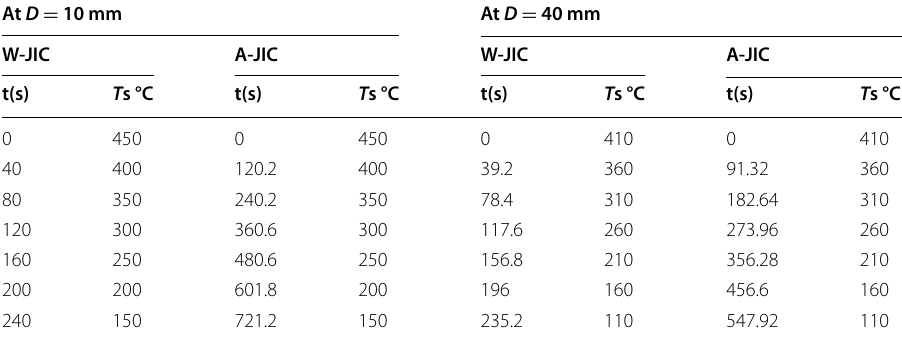
Table 10 Experimental and simulated data at 150 °C and 110 °C for H At D 10 mm At D =